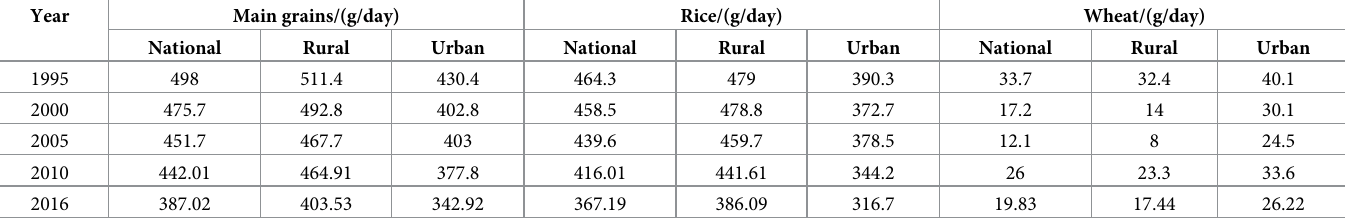
significantly by 110.98 g/day (Table 1), and the proportion of main grain intakes in the total food intakes decreased from 54.5% to 39.67% (Table 2). From the perspective of urban-rural differences, the evolution trend of main grains consumption in urban and rural areas was Table 1. Average per capita daily main grain